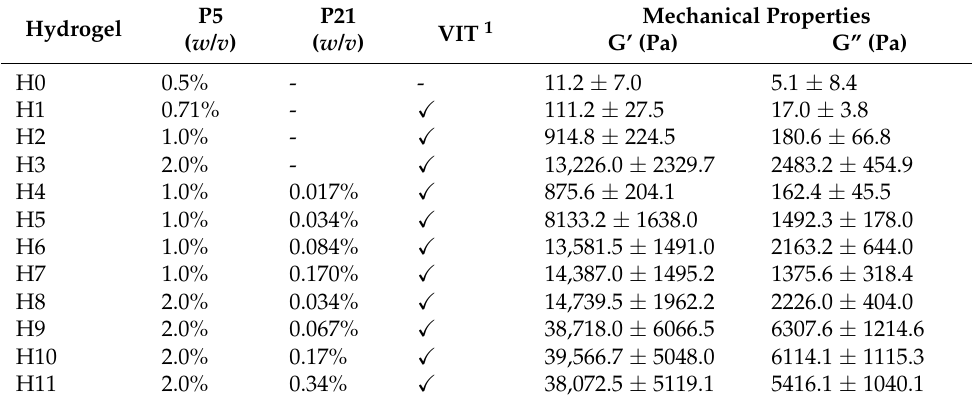
Table 1. Composition and mechanical properties of studied hydrogels.